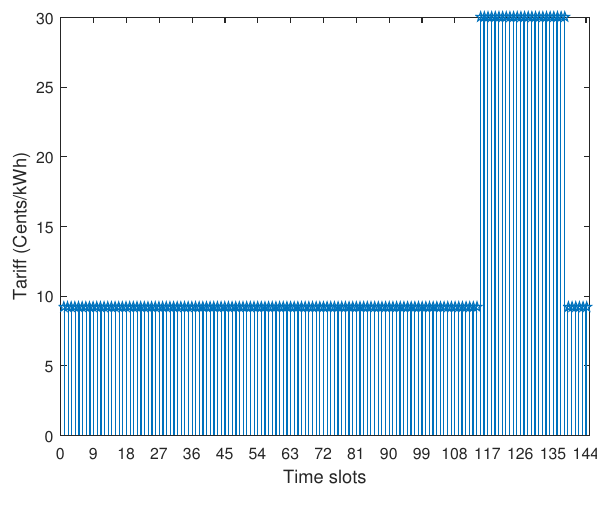
Figure 6. CPP scheme (2-stage).